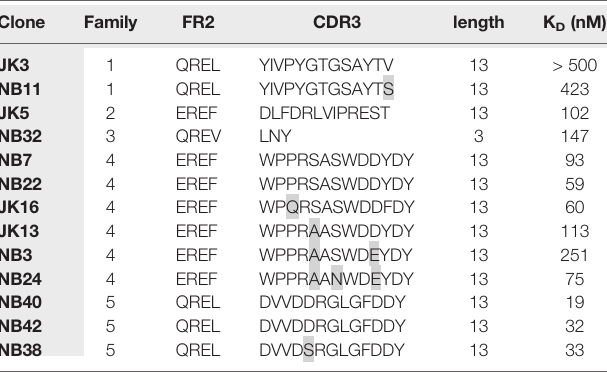
Families were designated according to highly similar CDR3 and shared framework sequences. Variant amino acid positions in the CDR3 within a family are highlighted in grey. Af fi nities (K D ) of nanobodies for the recombinant ecto-domain of CD38 were determined by biolayer